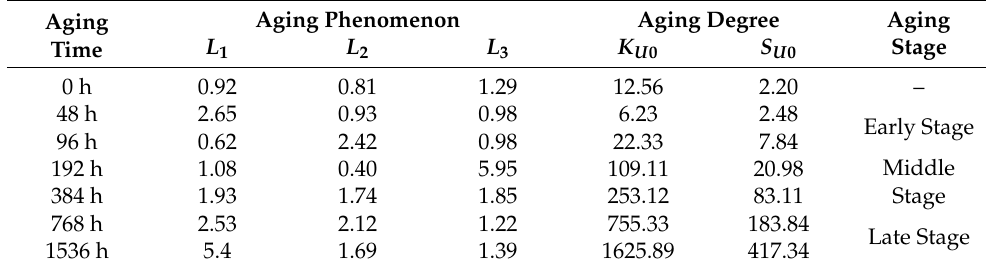
Table 2. Layering coefficients, K U 0 and S U 0 , versus aging